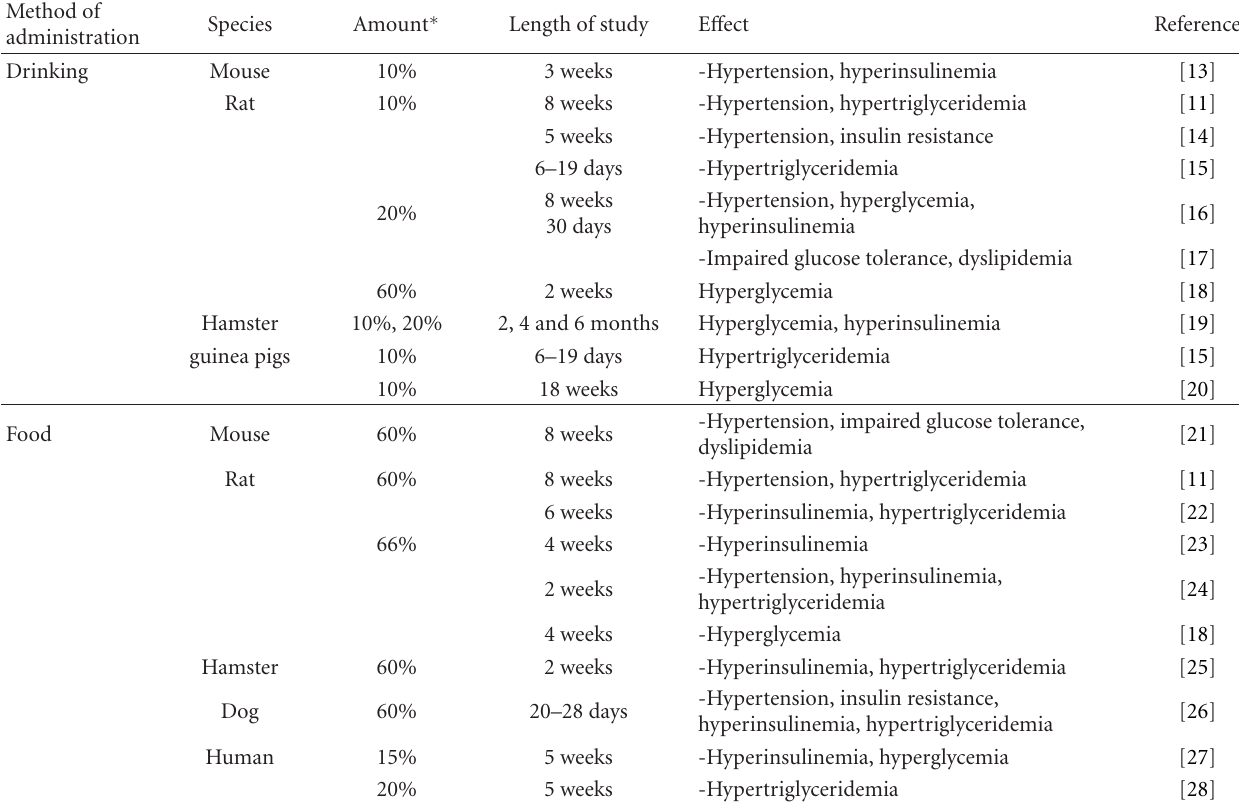
Table 1: The e ff ect of di ff erent routes of fructose administration in di ff erent species over di ff erent time periods. Method